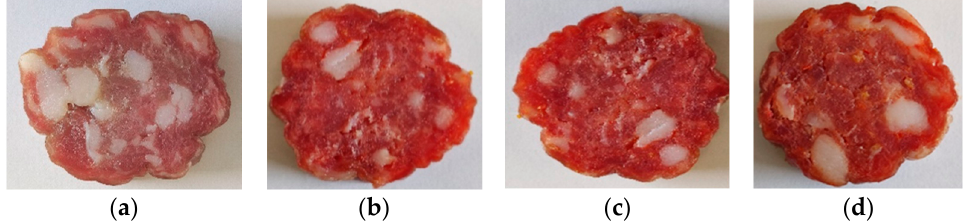
Figure 1. Cross-sectional appearance of fermented sausage: ( a ) control sample; ( b ) sample with 0.5% addition of TP; ( c ) sample with 1% addition of TP; and ( d ) sample with 1.5% addition of TP.